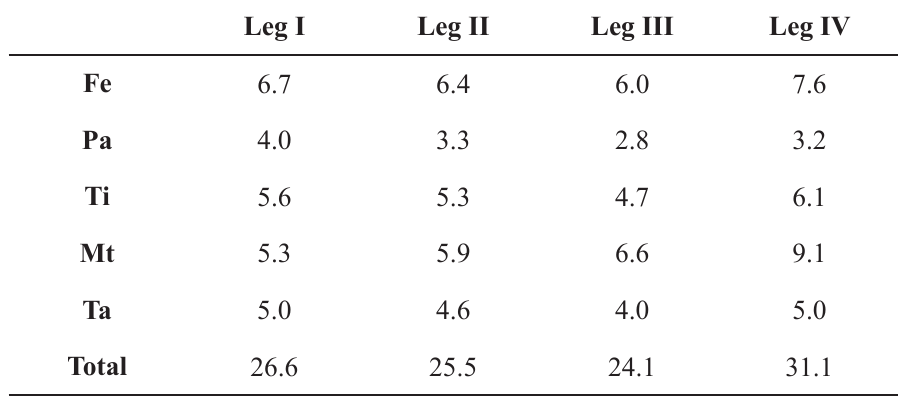
European Journal of Taxonomy 210: 1–21 Table 3. Diplura lineata (Lucas, 1857), ♂. Length of left leg articles (dorsal view).